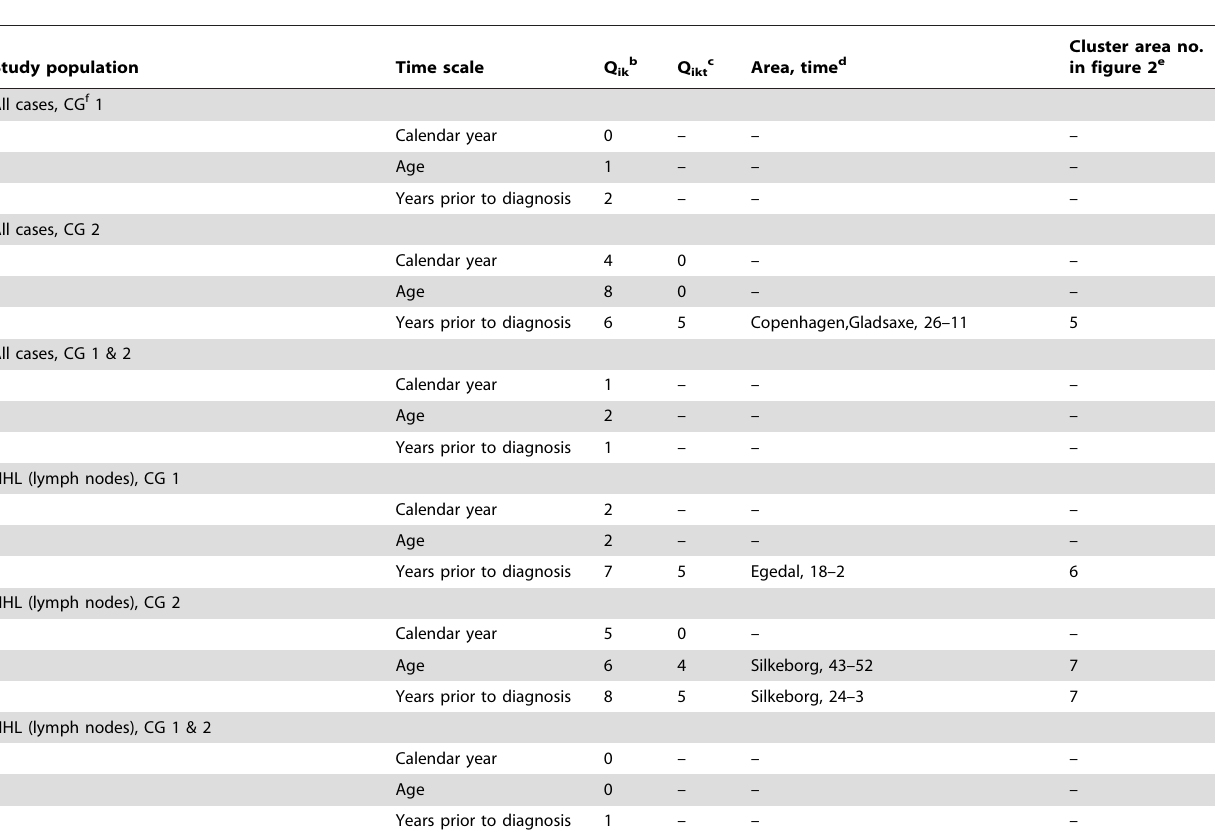
Table 2. Results of adjusted a space-time cluster analyses performed in SpaceStat, based on 15 nearest neighbours, 999 permutations, and by three different time